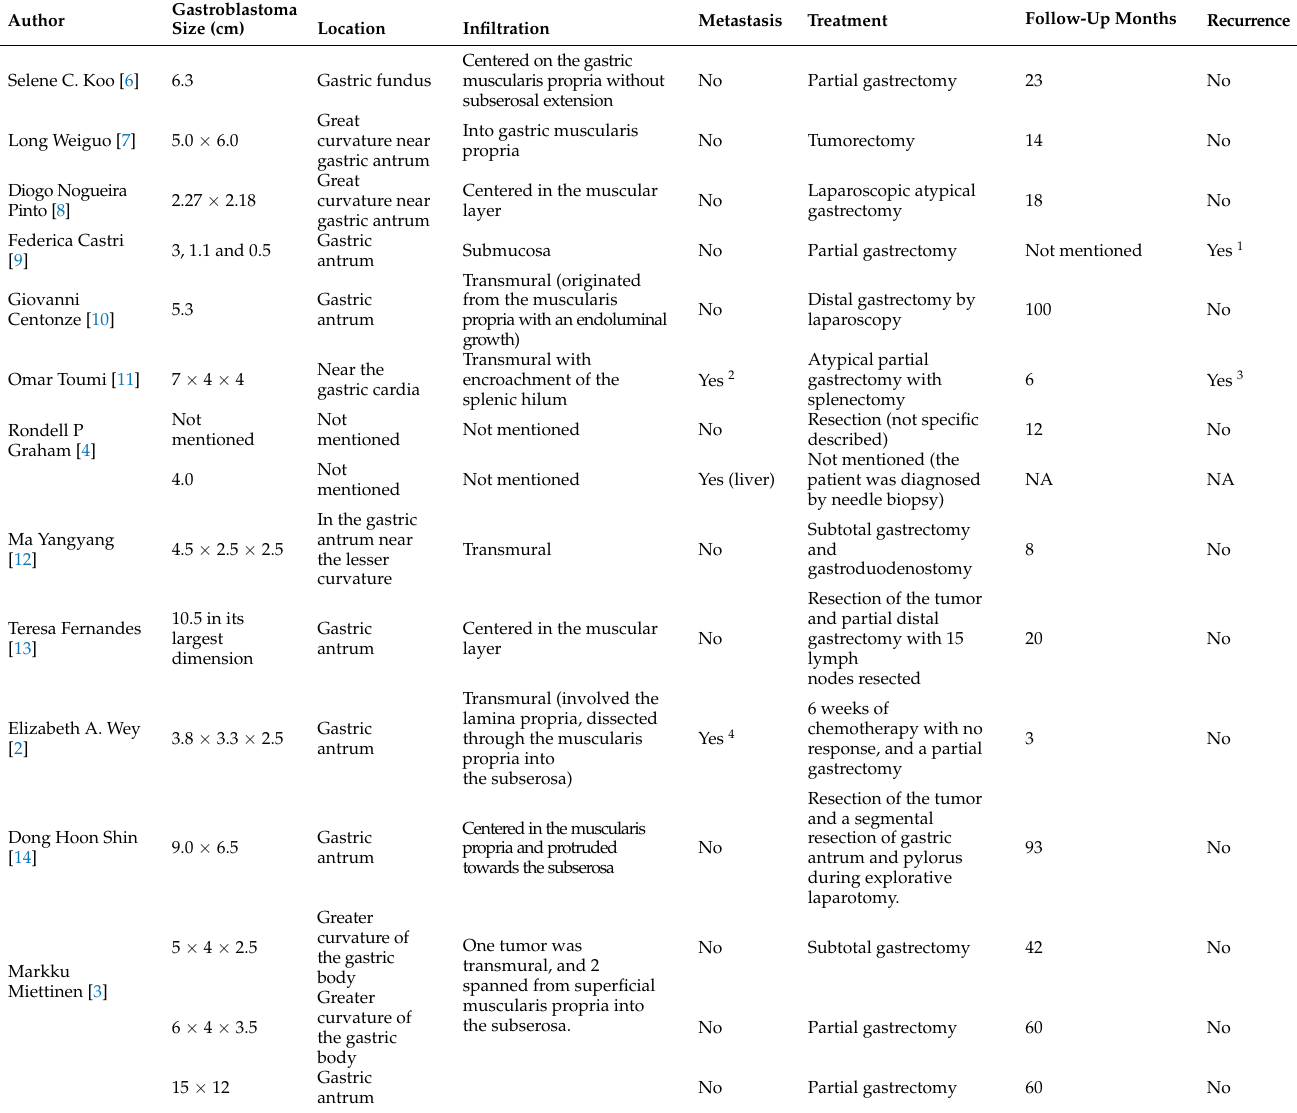
Table 3. Treatment choice and related follow-up information of reported